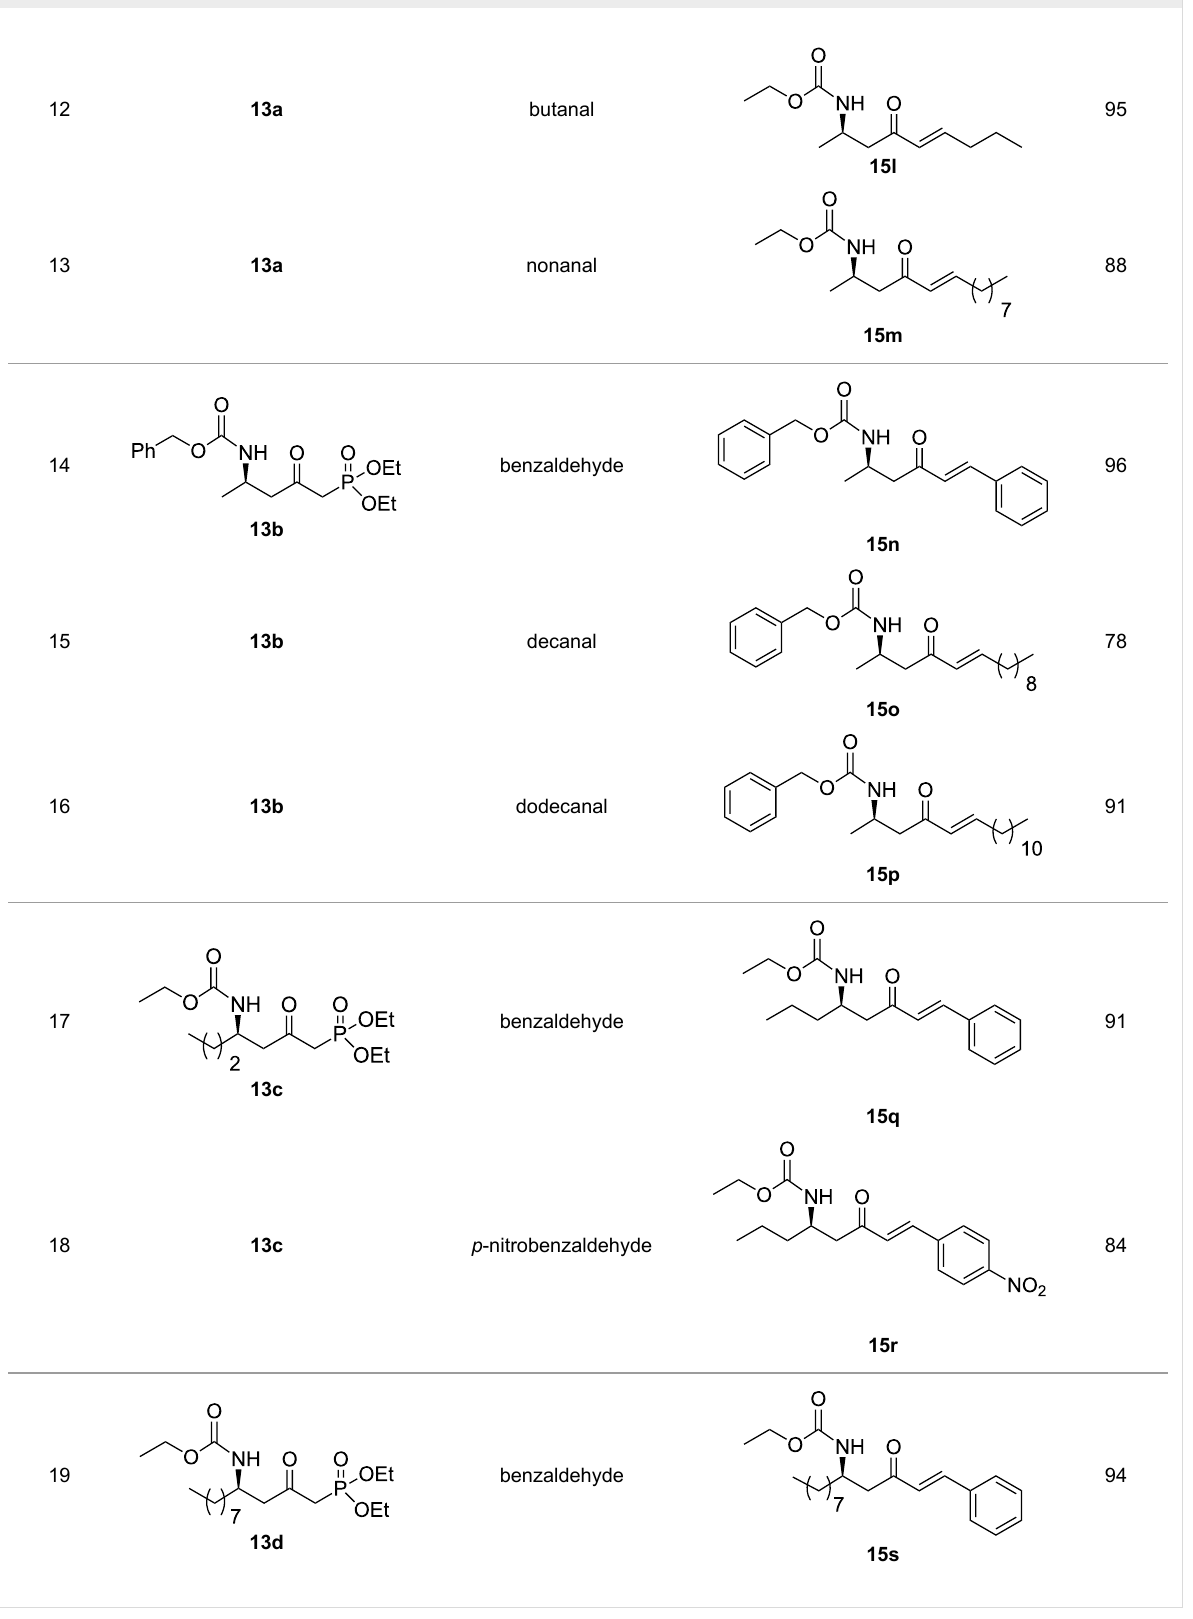
Table 3: Formation of the β ’-amino- α , β -unsaturated ketones 15 under Ba(OH) 2 conditions.